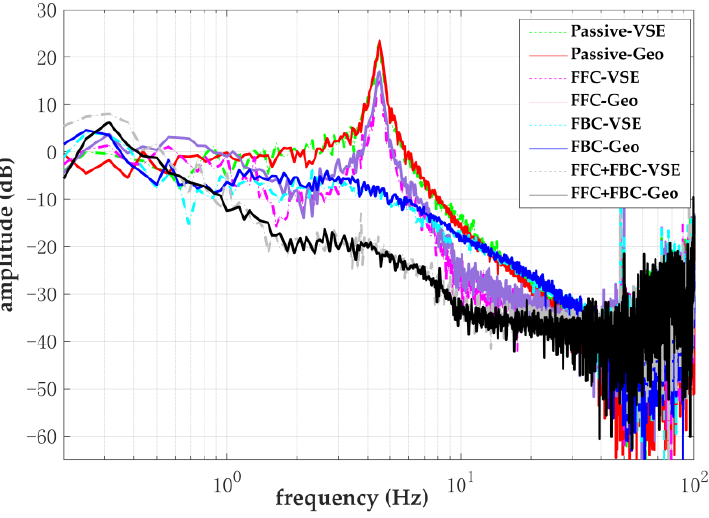
Figure 15. Contrasts between the transmissibility curves of internal geophones and external VSE-16D sensors under optimal learning parameters: Passivity, FFC, FBC, hybrid control (FBC + FFC).